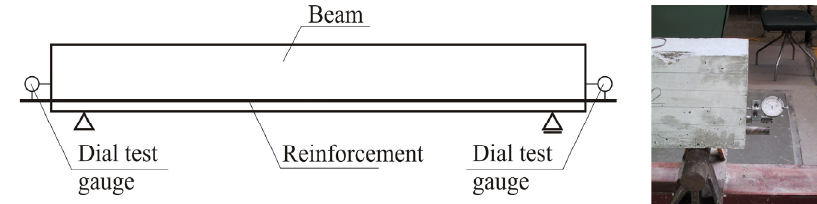
Figure 5. The instrumentation for bond checking.